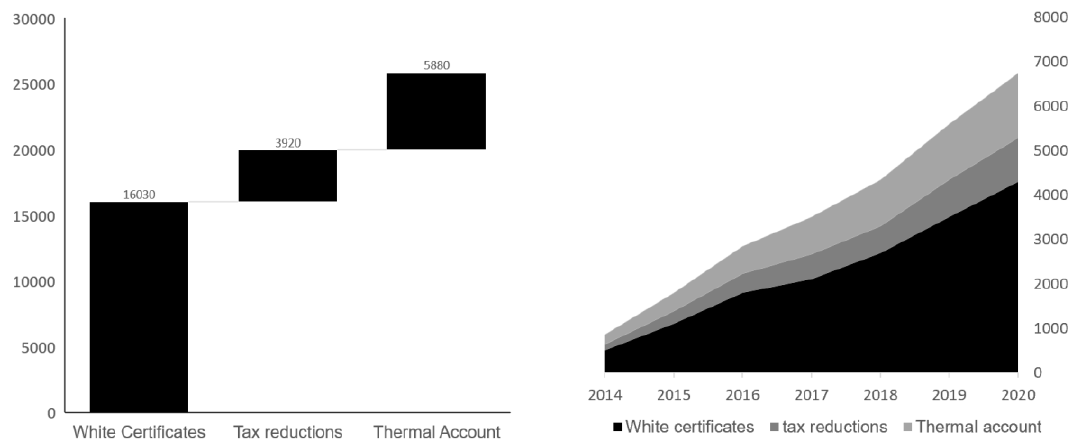
Figure 2. Breakdown of Italian cumulative savings toward EED Article 7. Source: own elaboration.